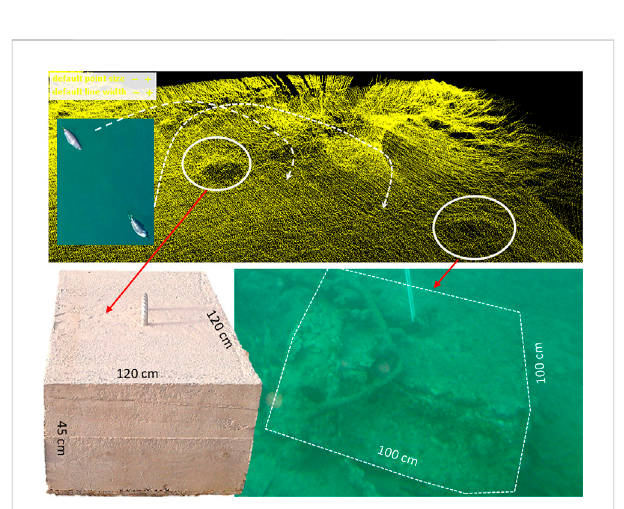
FIGURE 10 Detection of concrete blocks on the un fi ltered point cloud acquired during the smallest speed of a